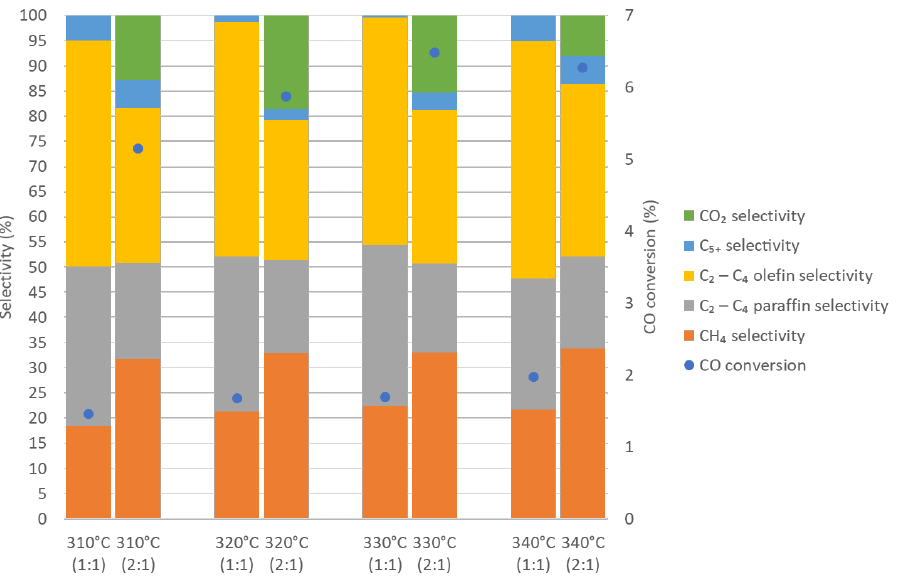
Figure 7. CO conversion and selectivities as a function of temperature and H 2 /CO 2 ratio. GHSV: 3400 h − 1 .